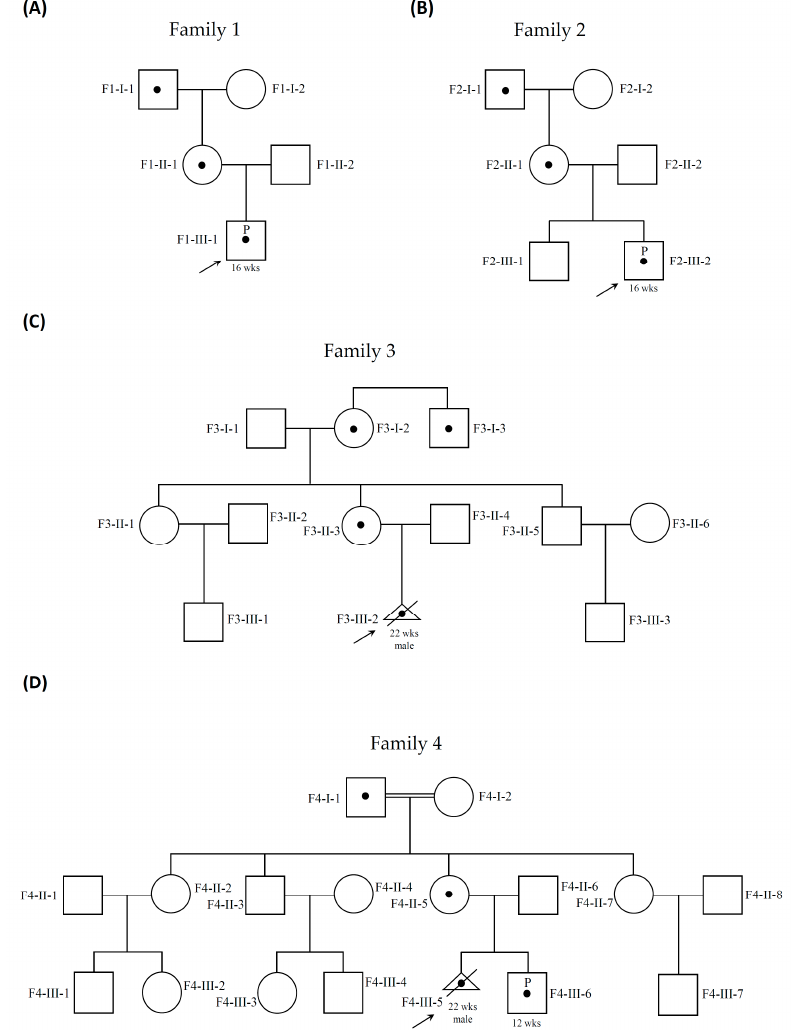
Figure 1. Pedigree information of four families involved chromosome number variations on X chromosome (X-CNVs) in male fetuses. ( A ) Family 1, ( B ) Family 2 and ( C ) Family 3 have X-CNVs on chromosome Xp22.31. ( D ) Family 4 has an X-CNV on chromosome Xq28. All the X-CNVs are traced back to at least one healthy male familial member in each family. Male indicated by square, female by circle, carrier by a dot in the middle of the symbol, pregnancy by a letter “P” in the middle of the symbol, termination of pregnancy by triangle with a slash, and the first case in a family seeking genetic testing by arrow. wks: weeks.